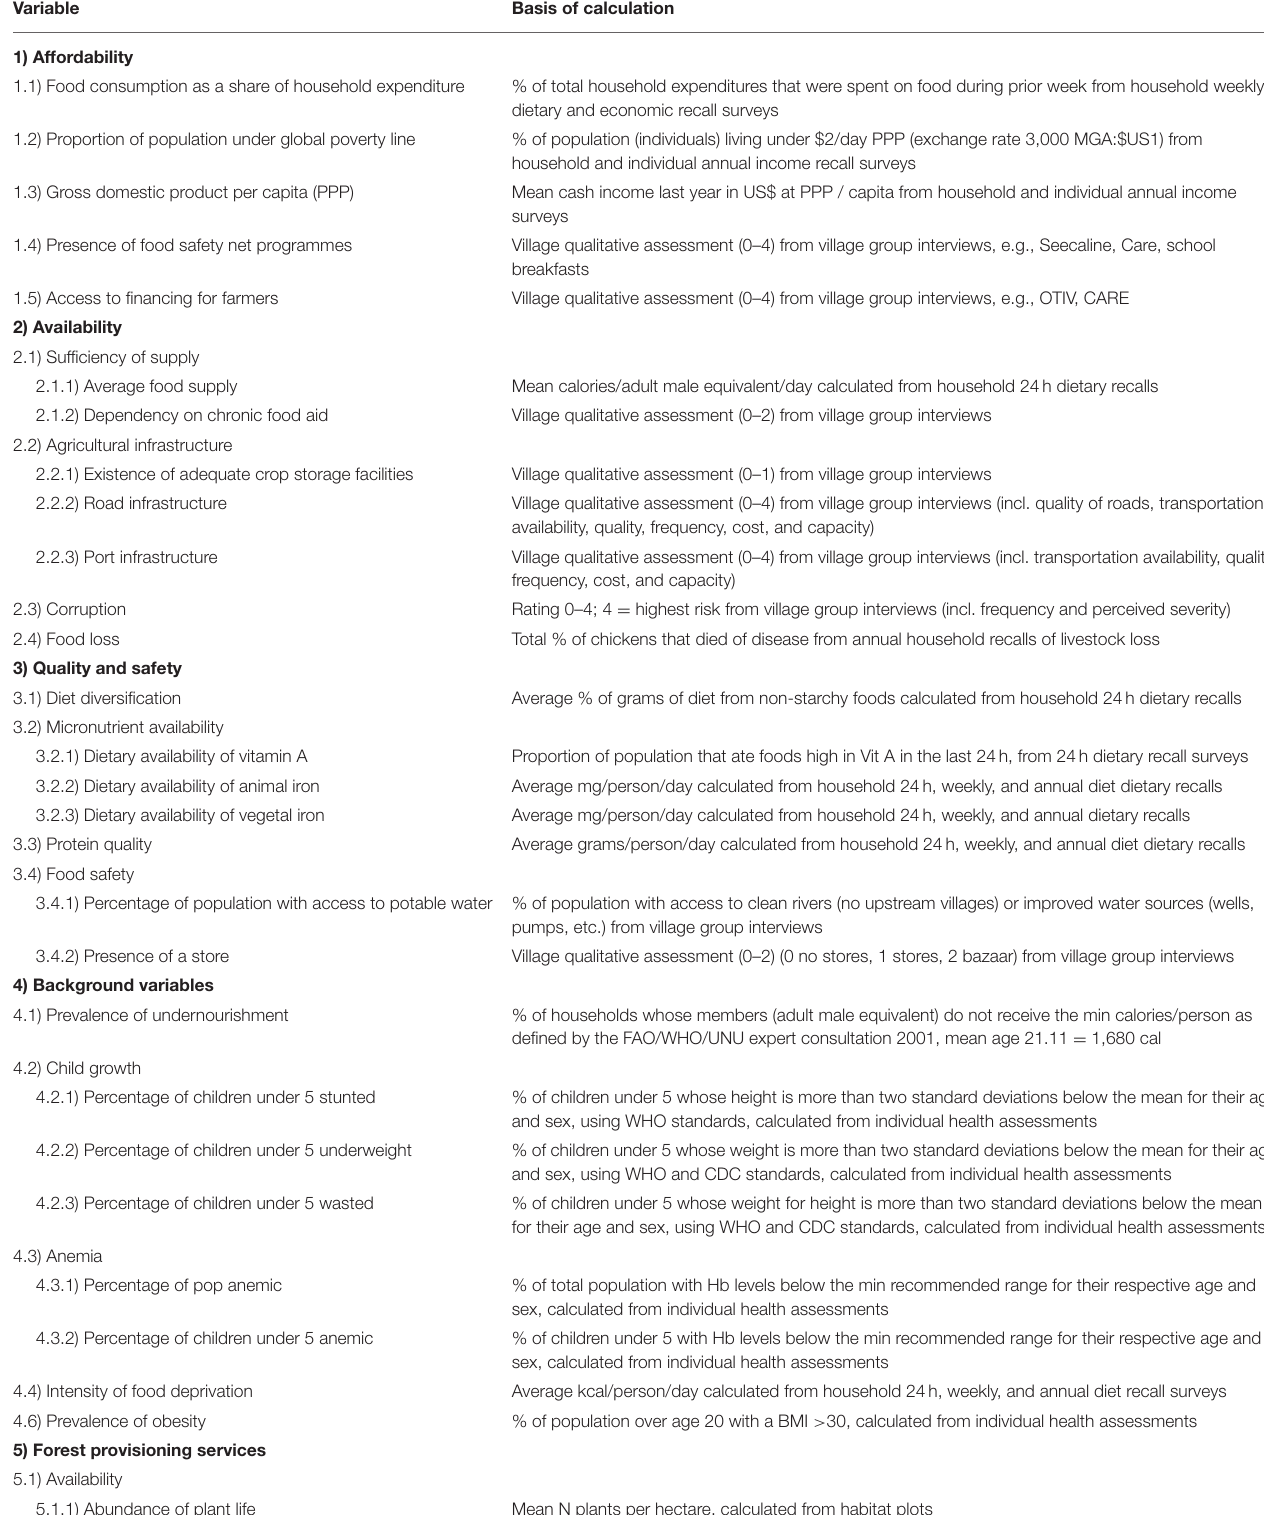
TABLE 2 | Units and methods used to calculate Masoala food security variables (2015).